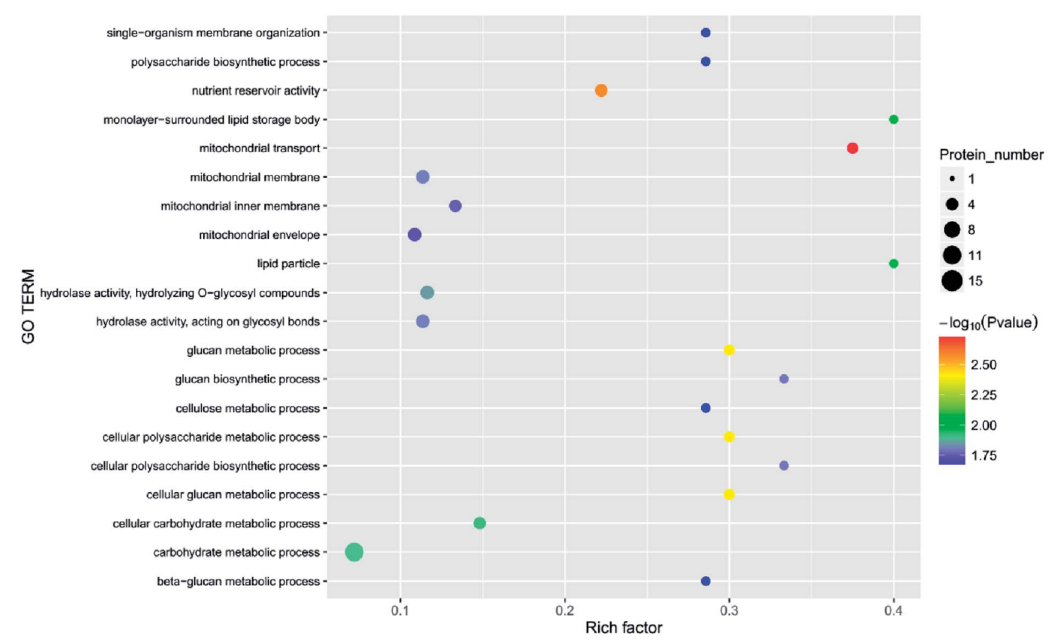
Figure 10. Gene Ontology classification of proteins in HBGH35 and Pusa Naveen ( ♀ ) based on their molecular function and metabolic interconversion enzymes.